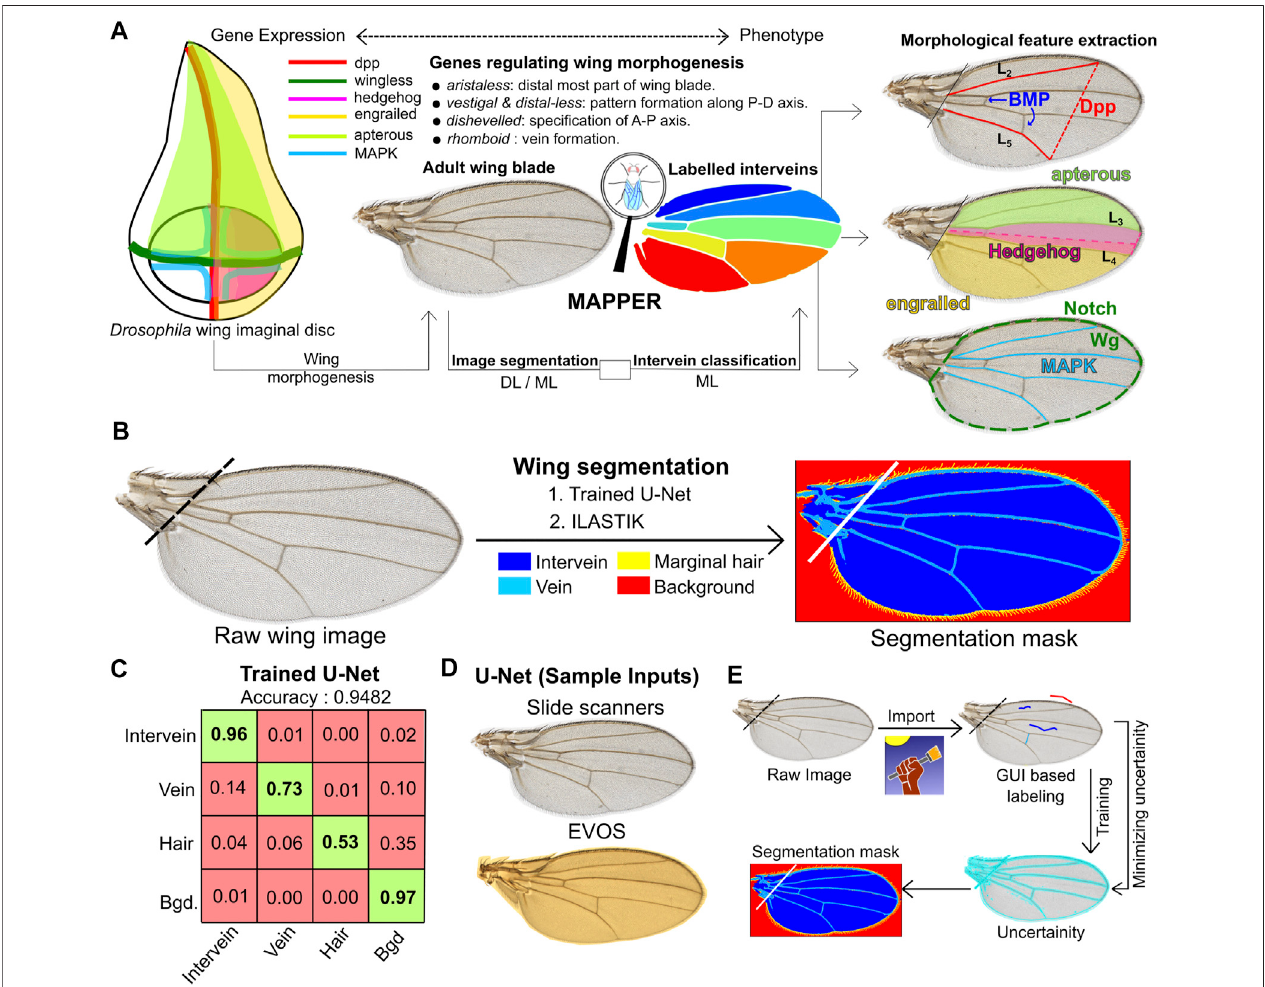
FIGURE 1 | MAPPER automates segmentation of wings. (A) Overview of the MAPPER pipeline. The wing imaginal disc development is regulated through the spatiotemporal patterning of multiple classes of genes (Williams et al., 1991; Campbell et al., 1993; Gómez-Skarmeta et al., 1996; Boutros and Mlodzik, 1999). During pupal stages, the wing blade is formed from the wing disc. The coupled image segmentation and intervein classi fi cation processes of MAPPER enables morphological feature extraction. (B) Segmentation of wings (left) is carried out for identi fi cation and labelling of different regions of interest (right) within the adult wing blade. Two methods of training are available: 1 The trained U-Net or 2 ILASTIK. (C) MAPPER utilizes the U-Net architecture, which consists of convolutional layers for feature extraction,followedbydeconvolutionlayerstoachievepixel-levelpredictions.Theconfusionmatrixshowshighpixelclassi fi cationaccuracyforaU-Nettrainedtoidentify different regions of interest. The numbers in the boxes represent the prediction accuracy for classi fi cation of a pixel into a class represented in the vertical labels against the true class in the horizontal labels. (D) Sample wings from multiple imaging sources that can be processed by MAPPER. (E) Schematic describing methodology followed by ILASTIK, an open source pixel classi fi er, for the purpose of pixel classi fi